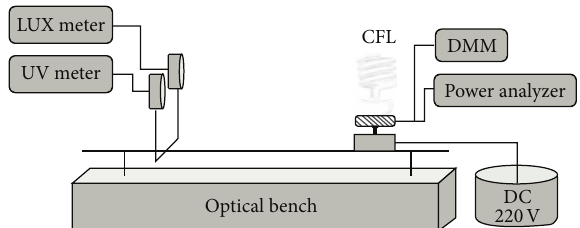
Figure 3: Schematic diagram of experimental set up for illuminance and UV irradiance